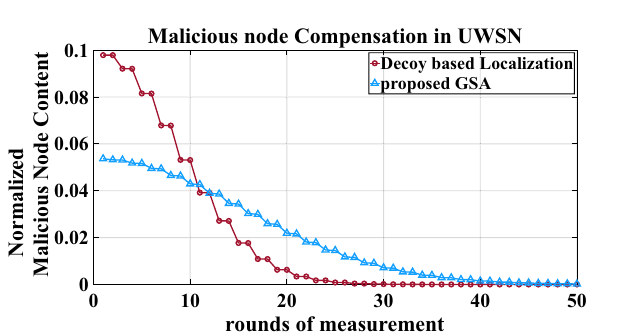
Figure 5. Malicious node compensation in